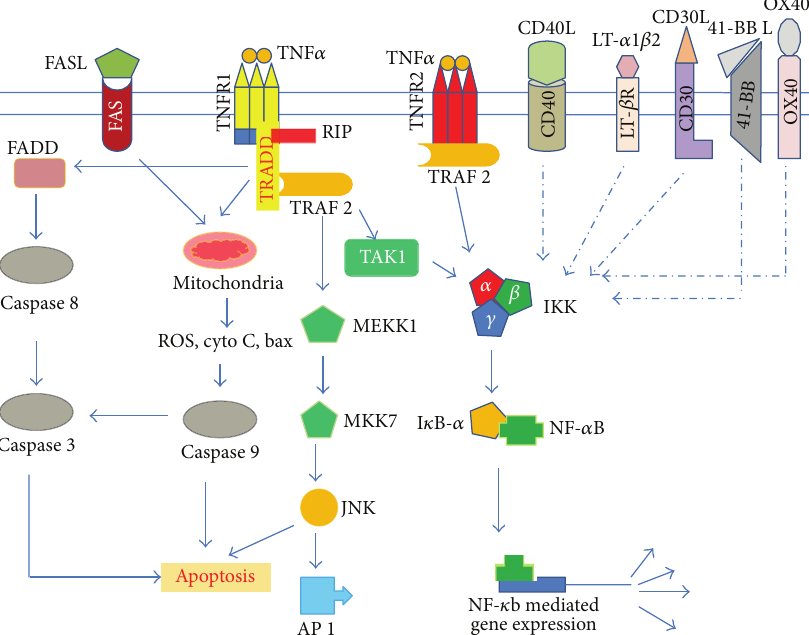
Figure 1: TNF and TNFR superfamily-mediated cell signaling. Binding of TNF-alpha to TNFRs results in activation of its receptors followed by recruitment of adaptor proteins (TRADD, FADD, TRAF, and RIP) in sequential manner that activates several signaling cascades leading to the activation of transcription factors NF-kappaB, AP-1, and/or caspase cascades. Most of the members of TNF superfamily activate also